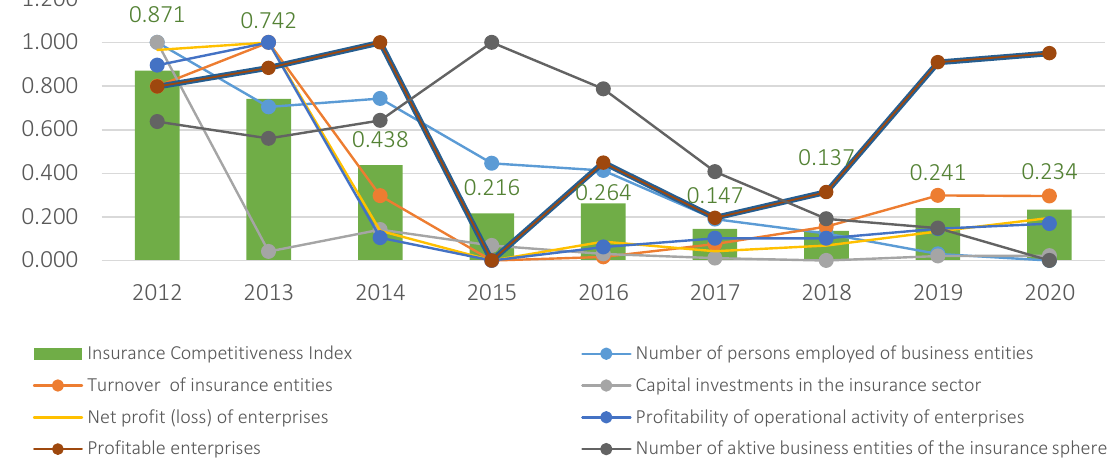
Figure 1. Dynamics of the competitiveness level of insurance in Ukraine in